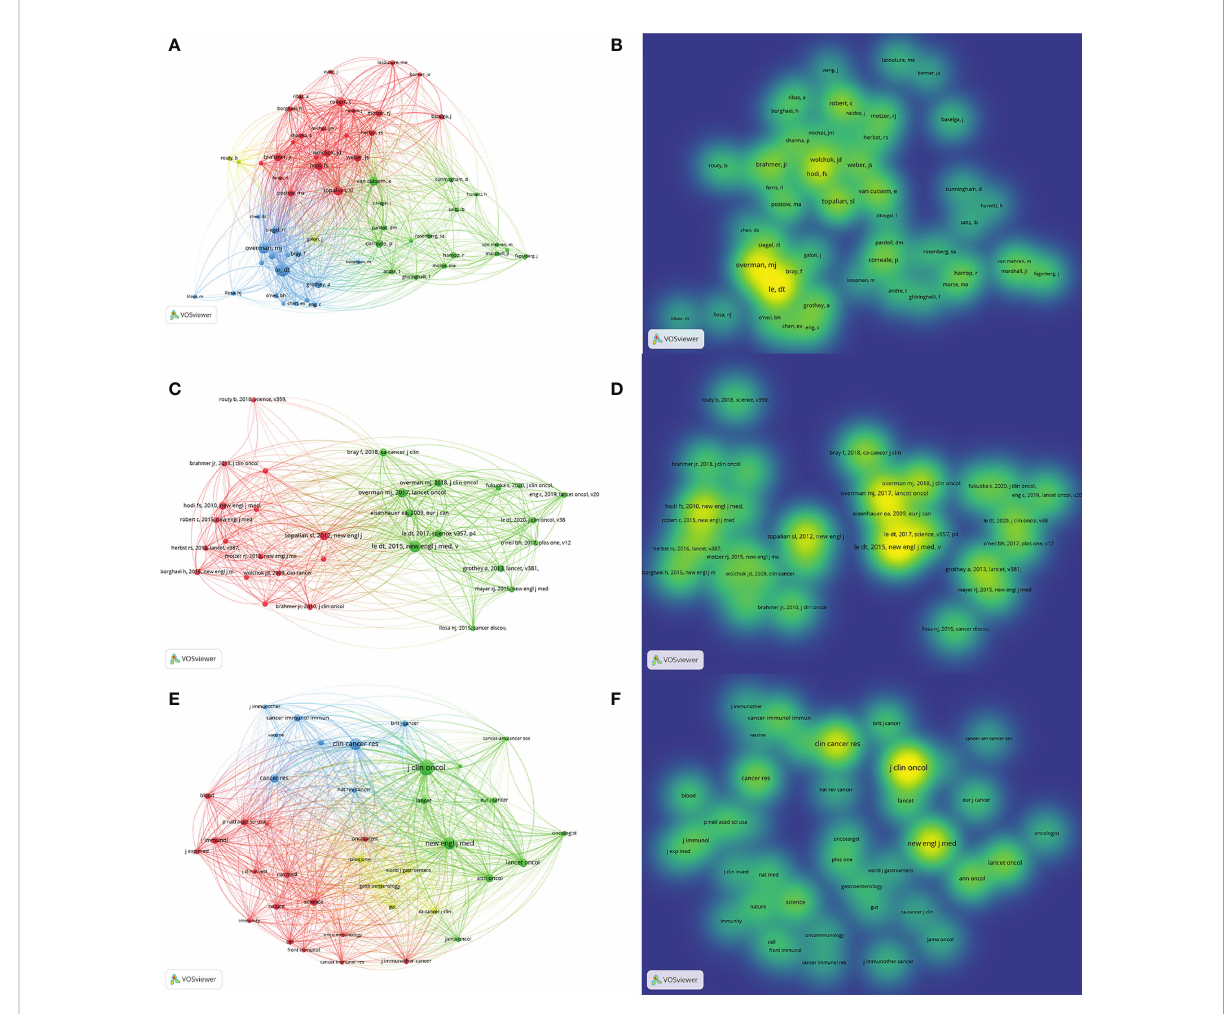
FIGURE 6 Citation and co-citation analyses of IRAEs for colorectal cancer. (A) Network map of authors who have been cited more than 5 times. (B) Distribution of authors according to the mean frequency of appearance. (C) Network map of references cited more than 10 times (D) Distribution of references according to the mean frequency of appearance. (E) Network map of documents cited more than 50 times (F) Distribution of documents according to the mean frequency of